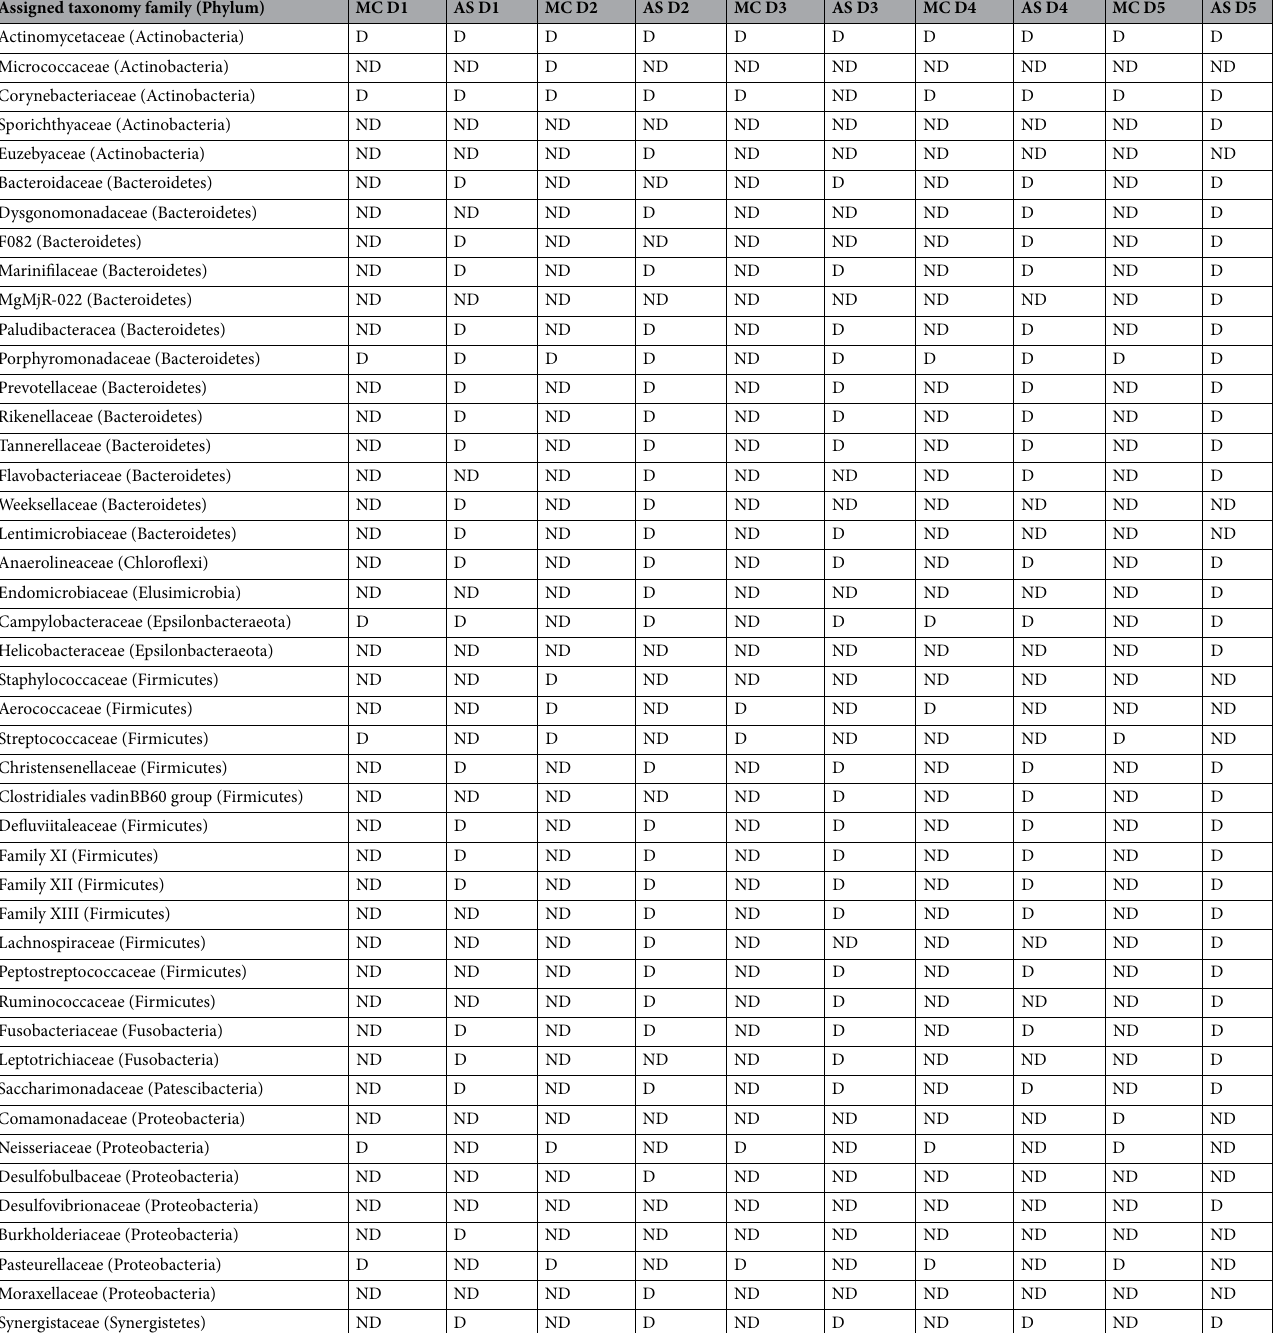
Table 3. Comparison of detection of individual families using microbial cultivation and amplicon sequencing. Designation D1 to D5 indicate individual dogs. MC Microbial cultivation, AS Amplicon sequencing, D Detected, ND Not